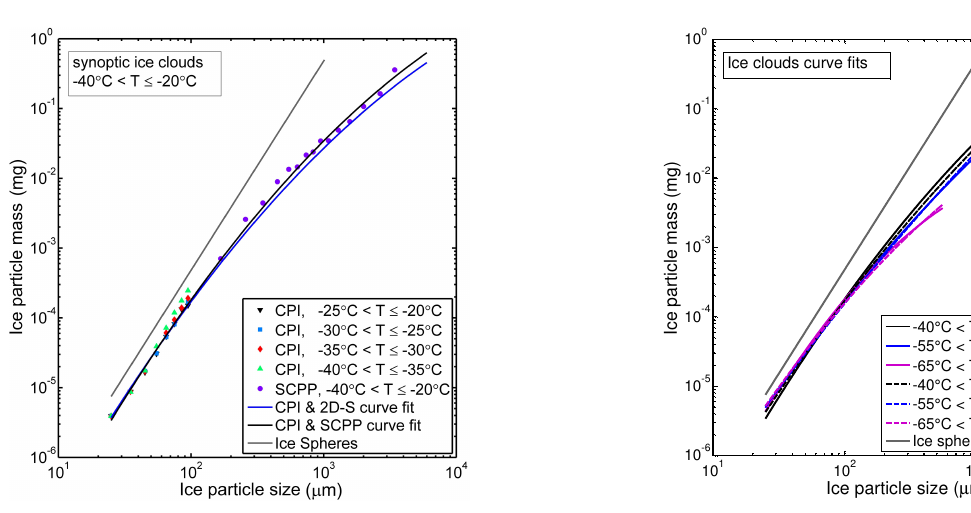
Figure 3. Dependence of ice particle mass on D for mean PSDs sampled from synoptic cirrus clouds during SPARTICUS for − 40 ◦ C <T = − 20 ◦ C (blue curve fit based on CPI and 2D-S data), where a single mean PSD is the mean of all PSD contained within a 5 ◦ C temperature interval. Also shown are CPI and SCPP data that are grouped into size bins for the indicated temperature ranges and the black curve fit based on these data (see Table 1 for equation). The gray line for ice spheres gives the maximum possible mass for a given D .